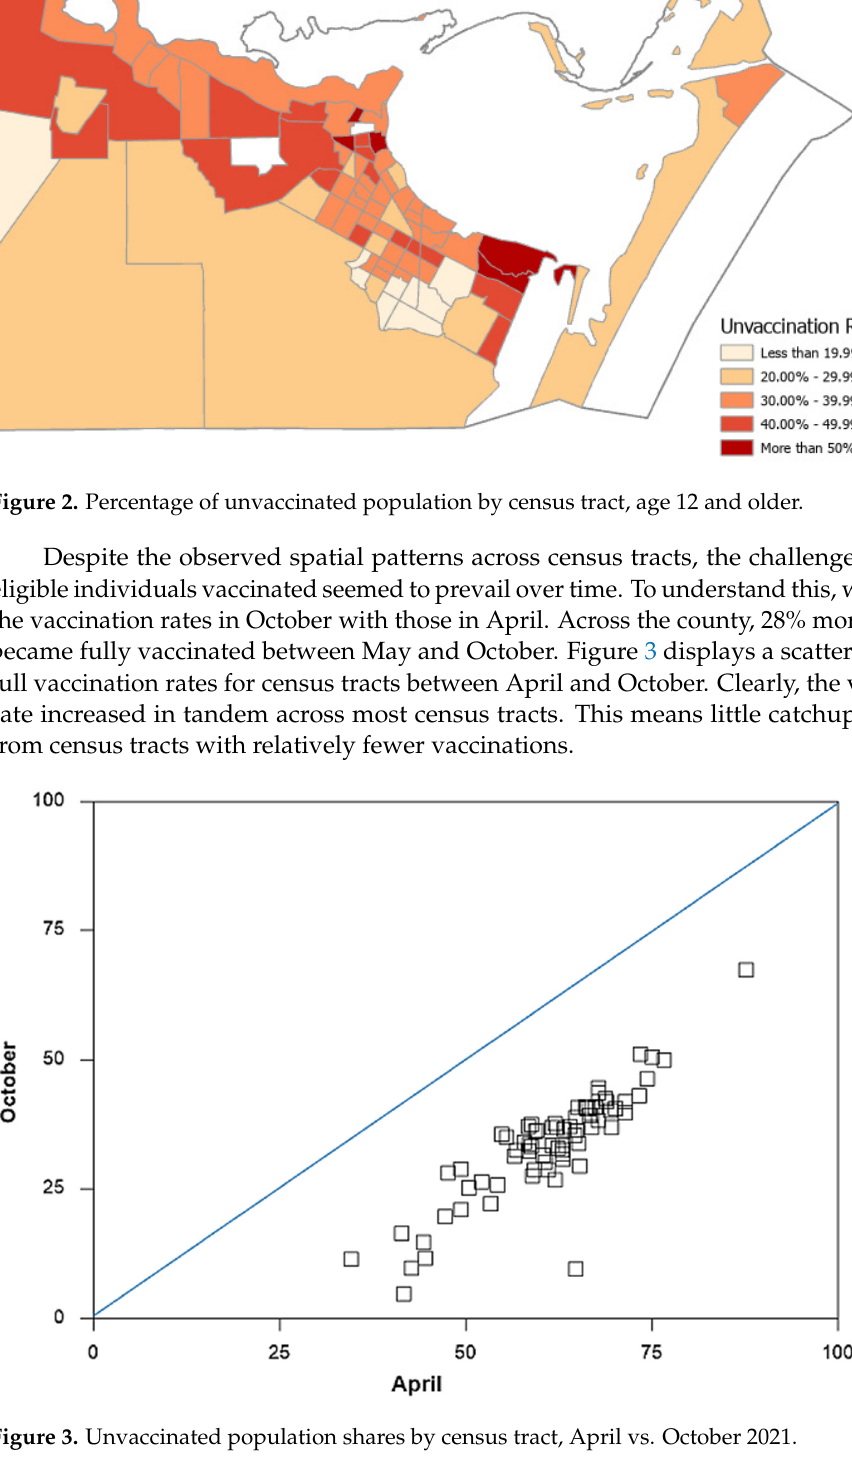
Figure 3. Unvaccinated population shares by census tract, April vs. October 2021.